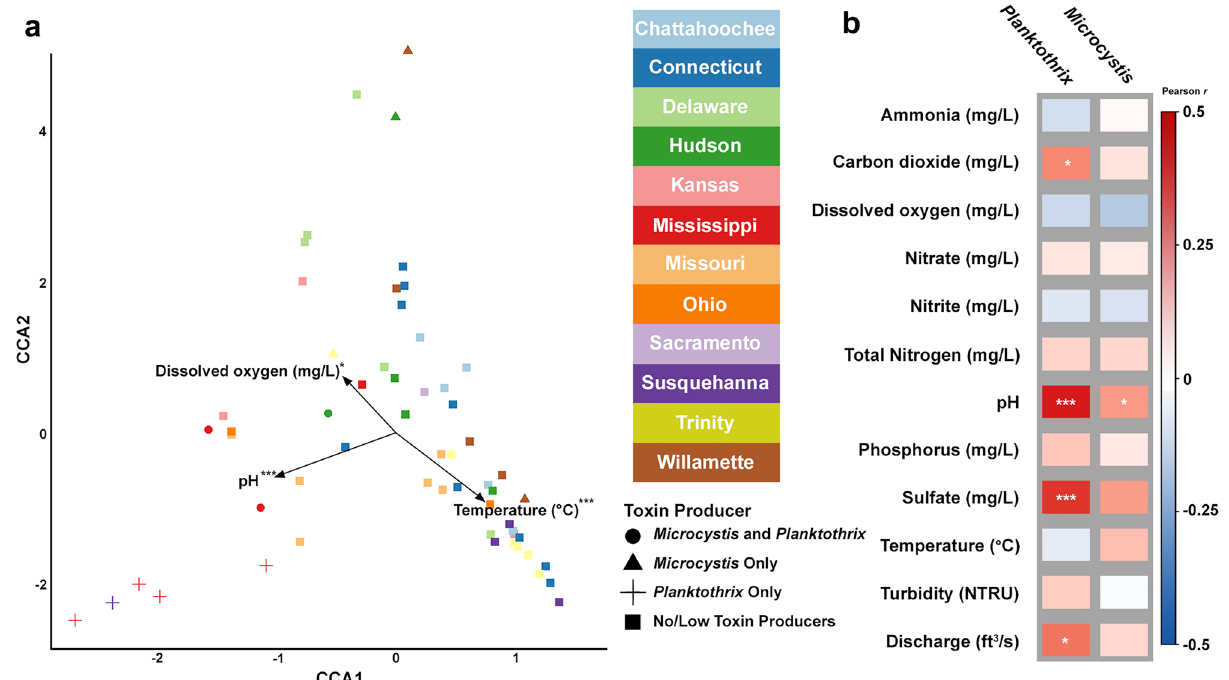
Figure 5. Analysis of cyanobacteria and potential toxin producing species in samples from U.S. rivers and their relationship to environmental variables. ( a ) Canonical Correspondence Analysis (CCA) plot for bacterial species within the phylum Cyanobacteria from each river. Colors indicate river identity. Shape indicates the category of potential cyanotoxin producer contained in each river above 1% relative abundance—either Microcystis spp., Planktothrix spp., a combination of the two, or no toxin producers (see Fig. 3 for details). The black arrows correspond to the environmental factors that significantly impacted cyanobacterial communities, where the size of each arrow represents degree of significance (longer arrow greater significance). ( b ) Pearson correlation between possible toxin producing genera and environmental variables. The color gradient on the right indicates Pearson correlation coefficients, with more positive values (dark red) indicating stronger positive correlations and more negative values (dark blue) indicating stronger negative correlations. The asterisks denote the significance levels (two-sided) of the Pearson correlation coefficients (n = 58 biologically independent samples). In ( b ) p values were adjusted for multiple testing using the Benjamini and Hochberg false discovery rate controlling procedure. For ( a,b ): *** p < 0.001, ** p < 0.01 and * p <